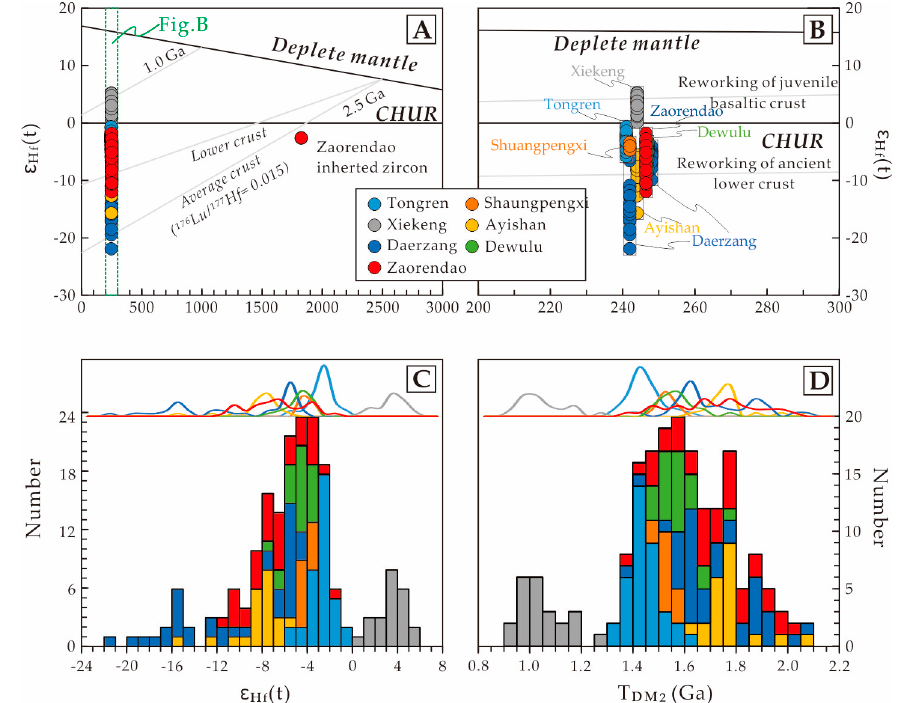
Figure 7. Plots of ε Hf (t) values vs. U-Pb ages for zircons from the diorite in the Zaorendao deposit ( A , B ). ( C ) Histogram, and frequency curves of ε Hf (t) values. ( D ) Histogram, and frequency curves of corresponding two-stage model age (T DM2 ). Date from the igneous rocks of Tongren-Xiahe-Hezuo district are shown (Date are from Reference [12] and references therein.